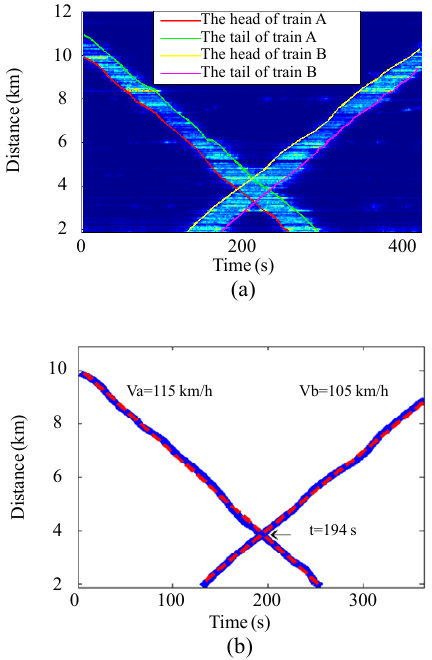
Fig. 22 (a) Vibration intensity vs space & time and the edges of every location period and (b) the two edges of the two trains’ heads (blue lines). The red lines are the fitting traces of the two trains.